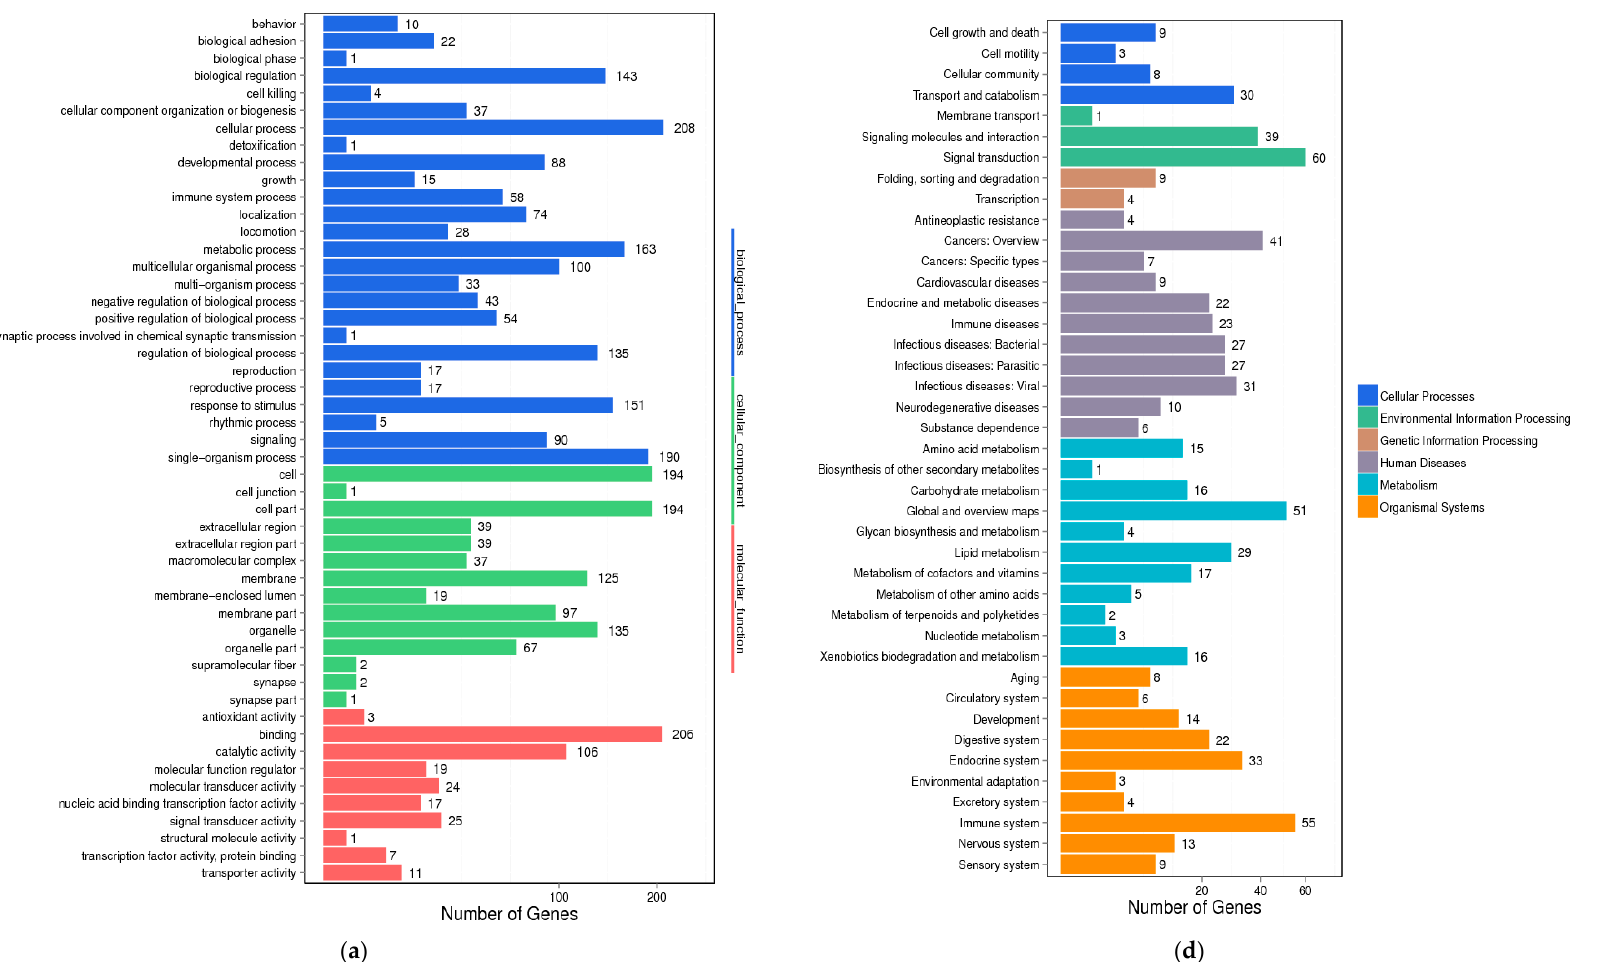
Figure 9. Differential gene expression analysis (HF vs CFTs). ( a ) GO functional classification on DEGs; ( b ) KEGG classification on DEGs.